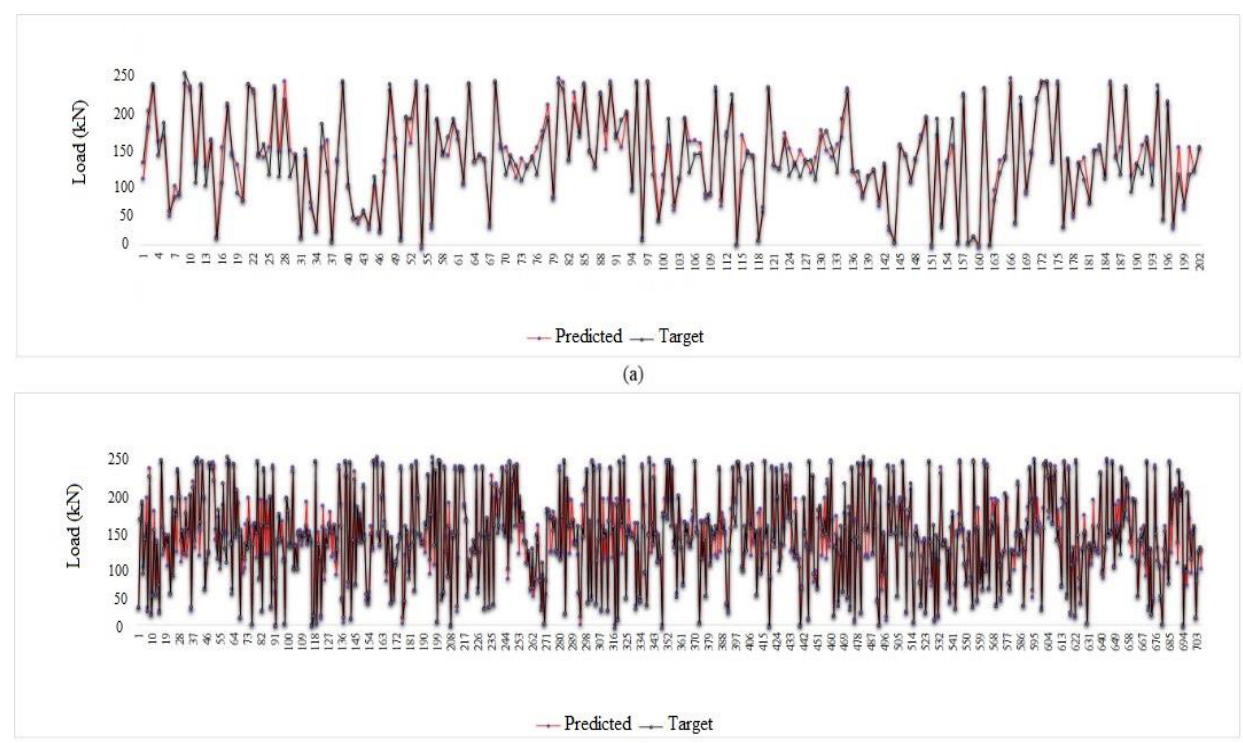
Figure 28. Tolerance diagram with respect to the ELM (seven inputs) prediction: ( a ) test phase, ( b ) train phase.